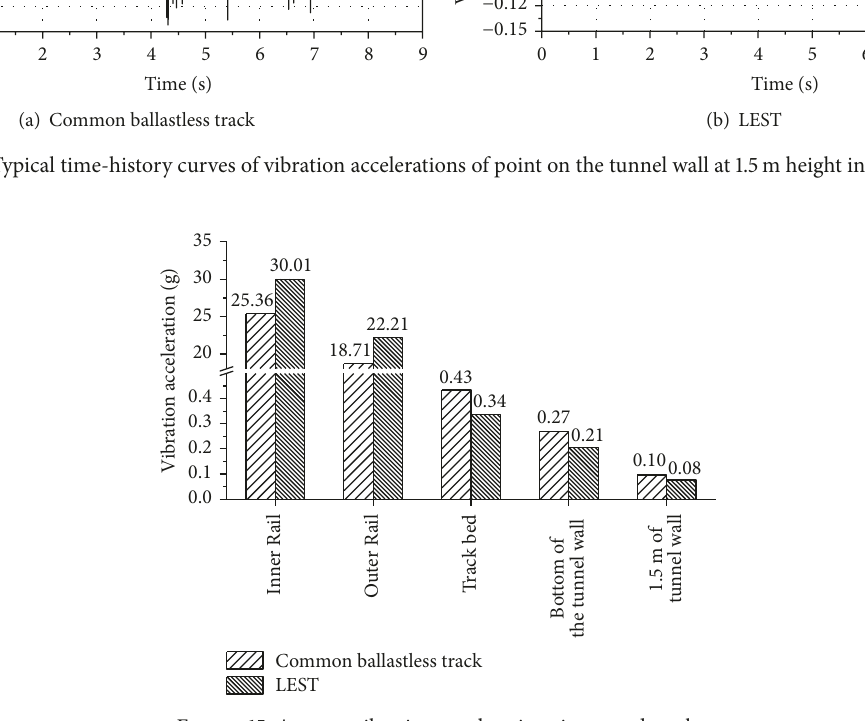
Figure 15: Average vibration accelerations in curved